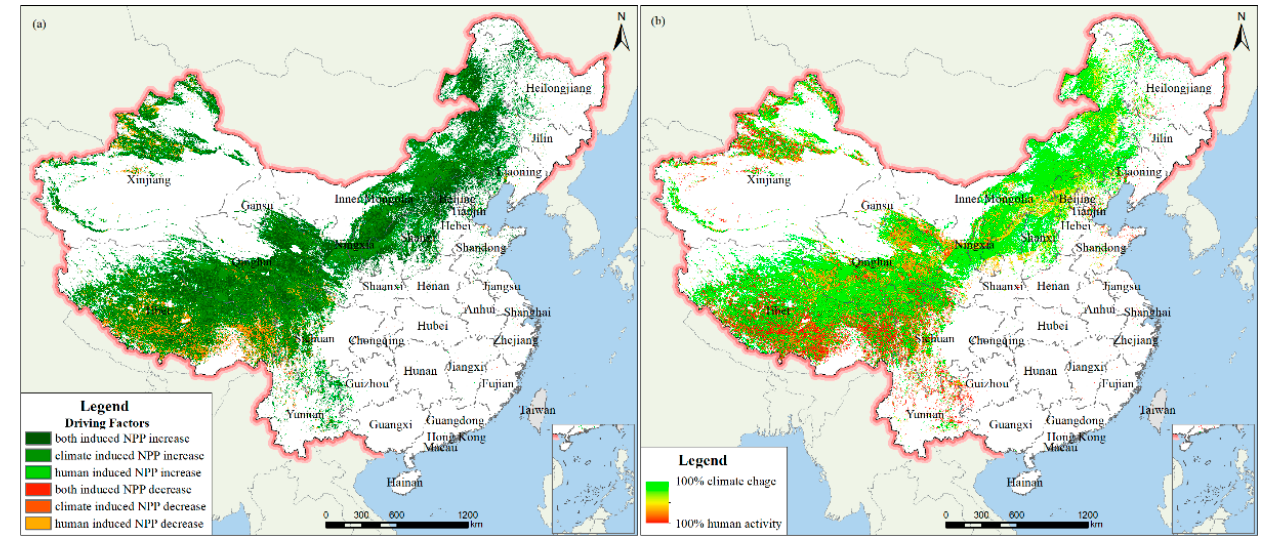
Figure 10. Spatial patterns of ( a ) driving factors and ( b ) contributions to ANPP changes. As shown in Figure 10b, in most of China’s grasslands, the influence of CC on ANPP was greater than HA. The few regions where the contributions of HA were greater than that of CC were mainly distributed in Southeast Tibet, Central and Northeastern Qinghai, Western Xinjiang, and Central Inner Mongolia. Generally, the contributions of CC to the changes of ANPP were 71.0%, whereas the effect of HA was